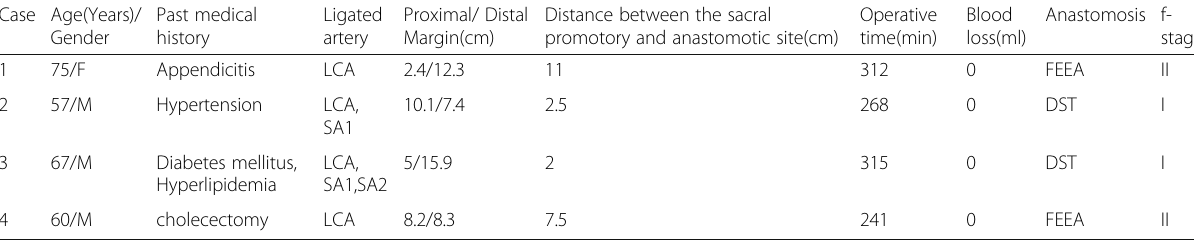
Table 1 Details of the operative procedures Case Age(Years)/